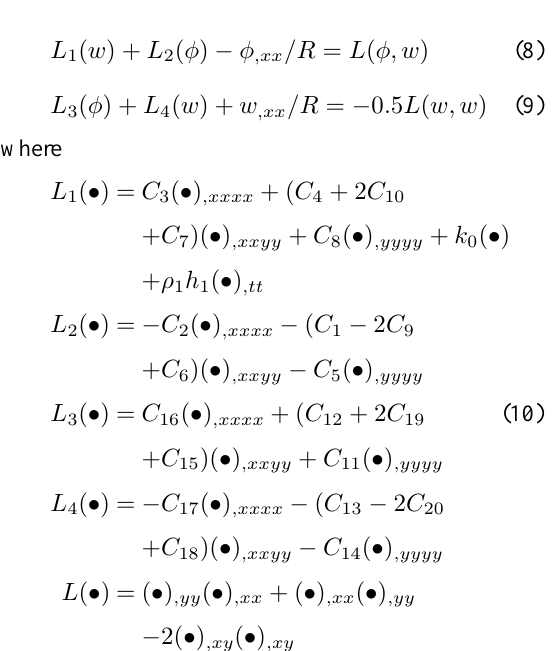
Fig. 1. Laminated cylindrical thin shell on elastic